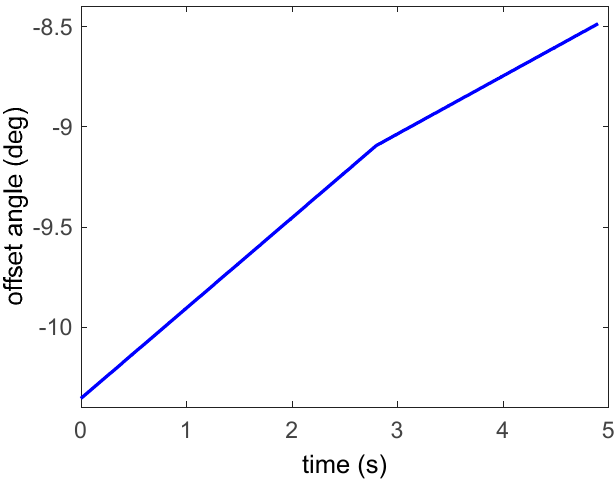
Figure 31. Identified time-varying offset angle offset u for second analysis period.